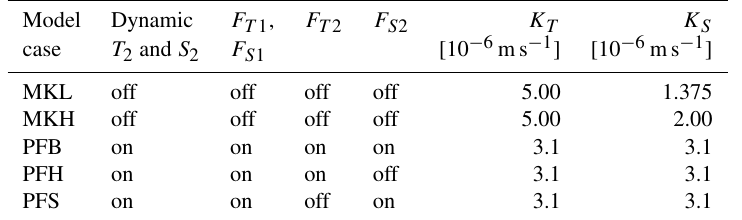
Table 1. Overview of the different cases considered and values for the diffusivity parameters for heat ( K T ) and salt ( K S ) transfer between the two layers for each case. A model component can either be included (“on”) or excluded (“off”). The model component “dynamic T 2 and S 2 ” stands for an active subsurface layer. If this component is excluded, the setup uses a subsurface layer with constant density. If either F T 2 or F S 2 is excluded, the background value corresponding to the flux is set constant. The model components containing “ F ” represent fluxes with subscripts representing the horizontal heat ( T ) and salt ( S ) fluxes in either the surface (1) or subsurface (2) layer.